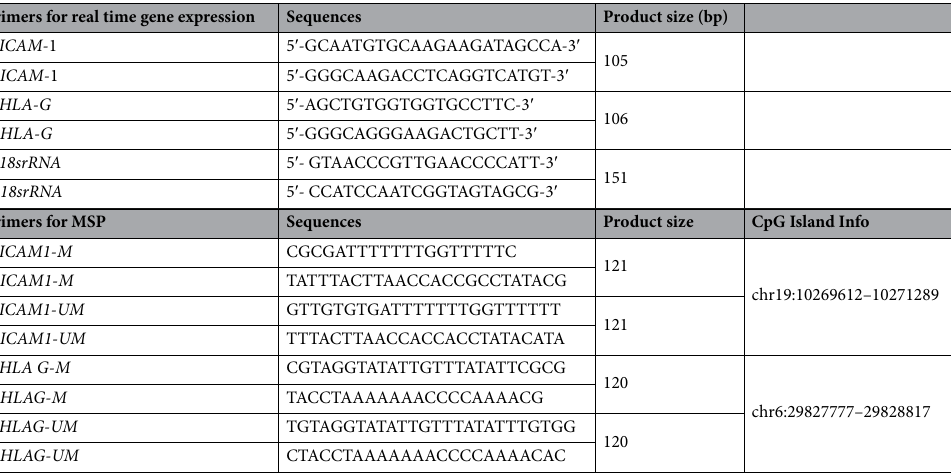
Table 1. Real time gene expression and MSP primers sequences.